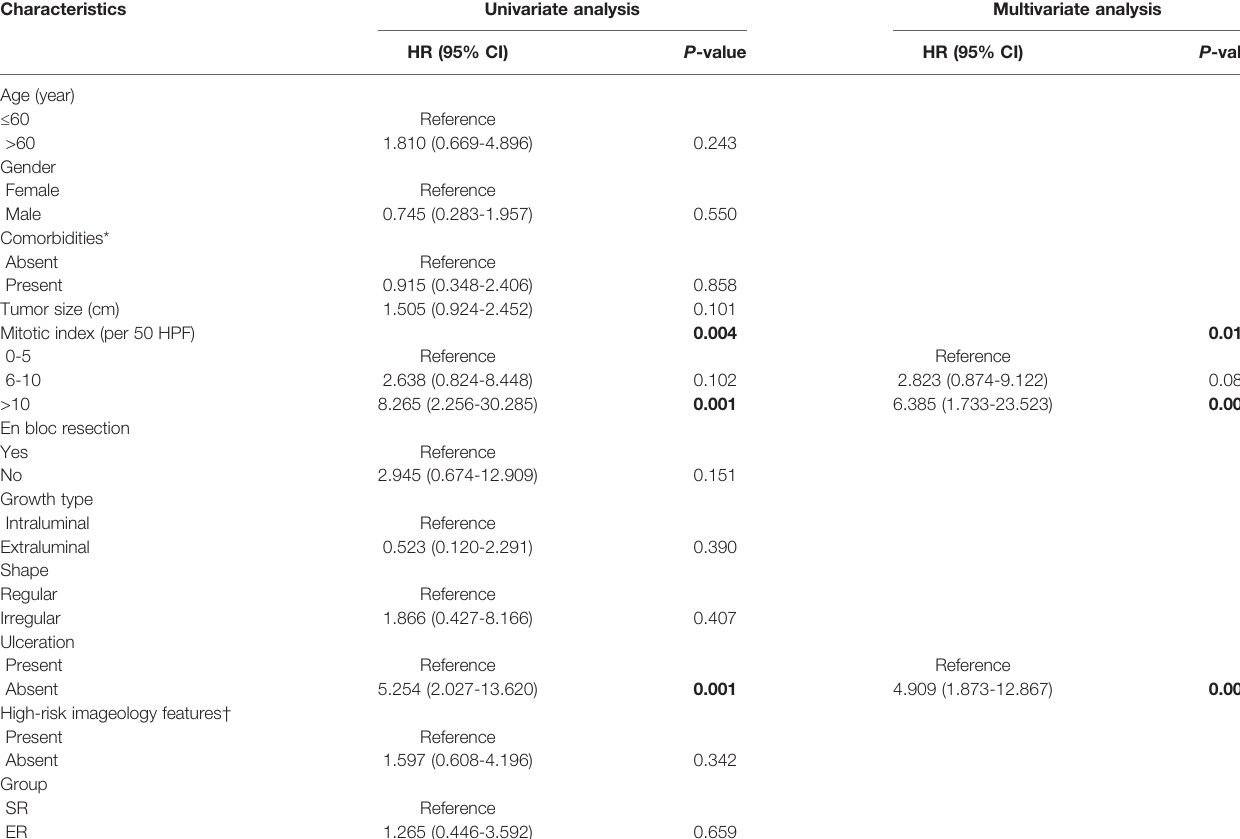
TABLE 6 | Univariate and multivariate of the clinicopathological factors for progression-free survival.